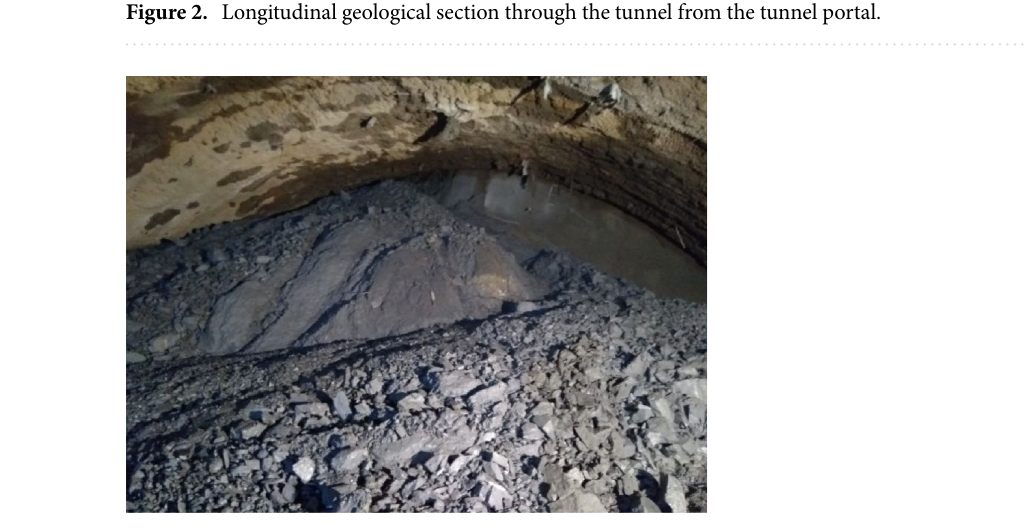
Figure 2. Longitudinal geological section through the tunnel from the tunnel portal.